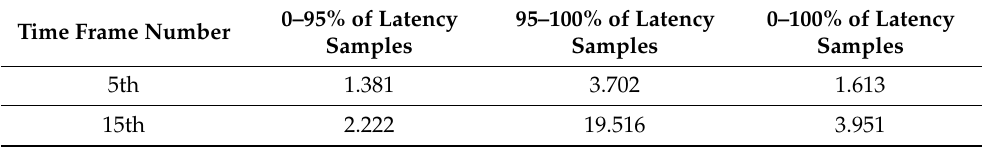
Table 1. Average latency values in milliseconds for the time frames.